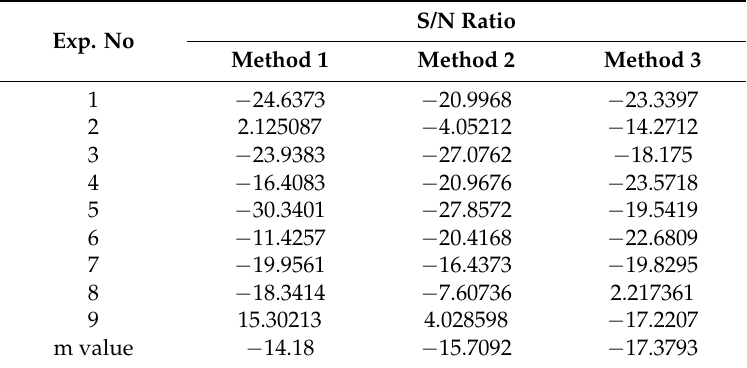
Table 14. S/N ratio of each experiment with various